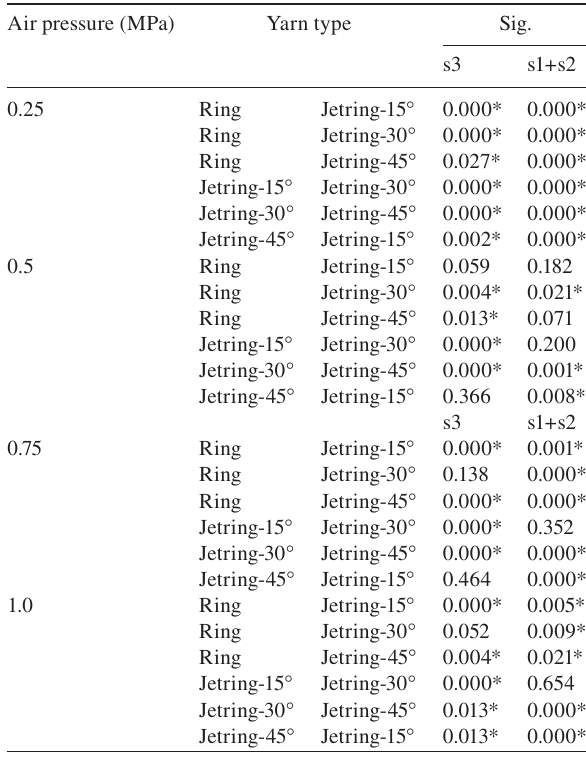
Figure 8 Zweigle hairiness (s3) values.